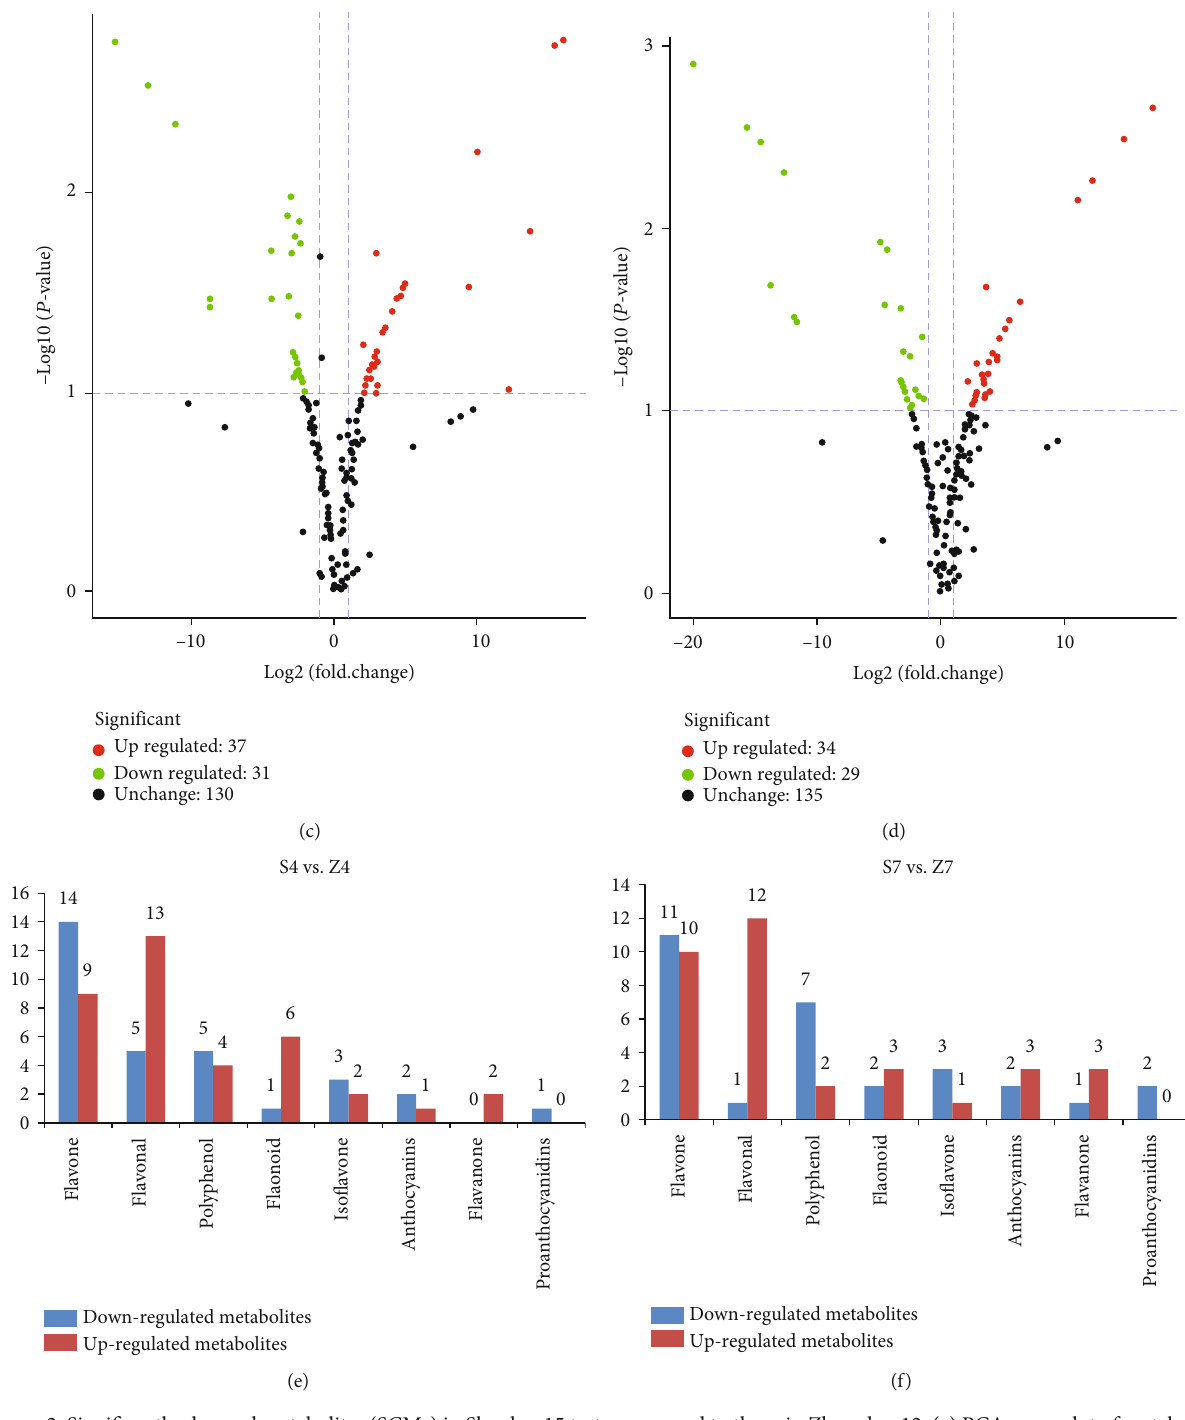
Figure 2: Signi fi cantly changed metabolites (SCMs) in Shanhua15 testa compared to those in Zhonghua12. (a) PCA score plot of metabolites pro fi les from the Shanhua15 and Zhonghua12 testa. Every point represents an independent biological replicate. (b) Expression patterns of secondary metabolites revealed by metabolomic analysis. (c, d) Volcano plot of the metabolites between Shanhua15 and Zhonghua12. (e, f) Number of SCMs in di ff erent categories. S4, Shanhua15 R4 pod period; Z4, Zhonghua12 R4 pod period; S7, Shanhua15 R7 pod period; Z7, Zhonghua12 R7 pod period. -1, -2, and -3 represent the three biological